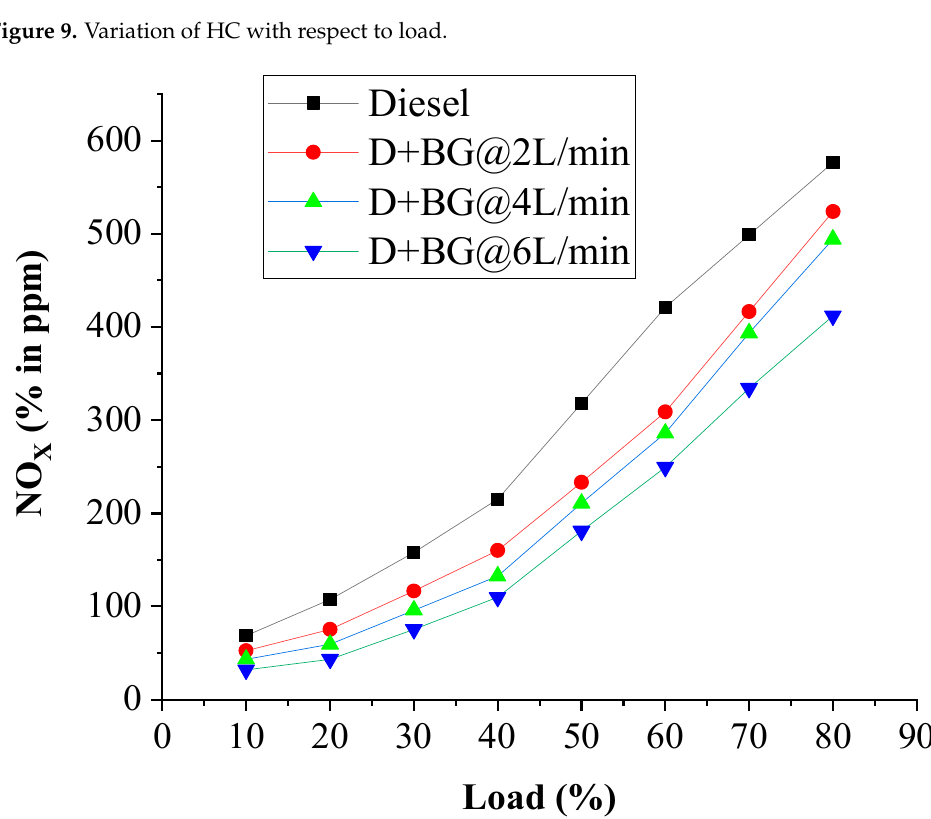
Figure 10. Variation of NO X with respect to